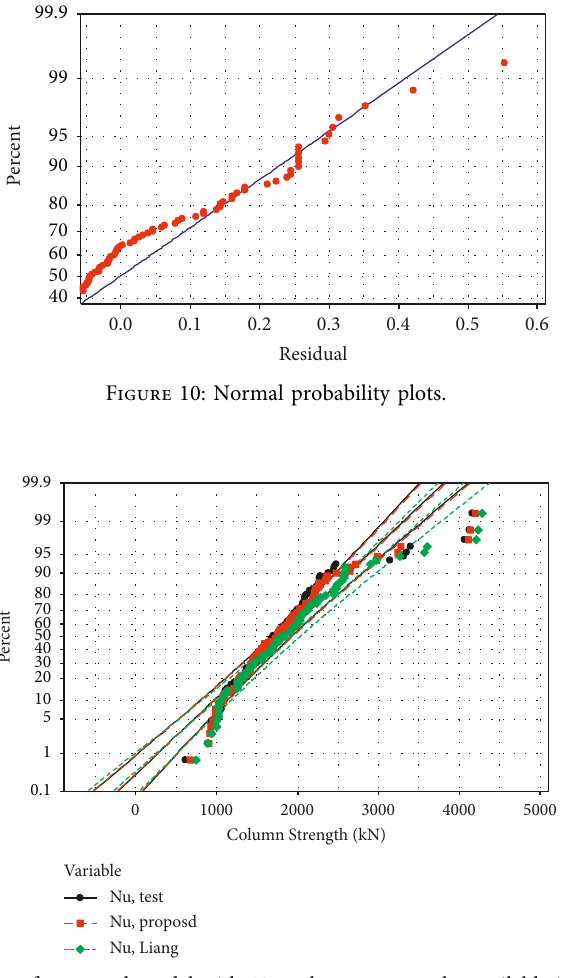
Figure 11: Validation of proposed model with 105 column test results available in various